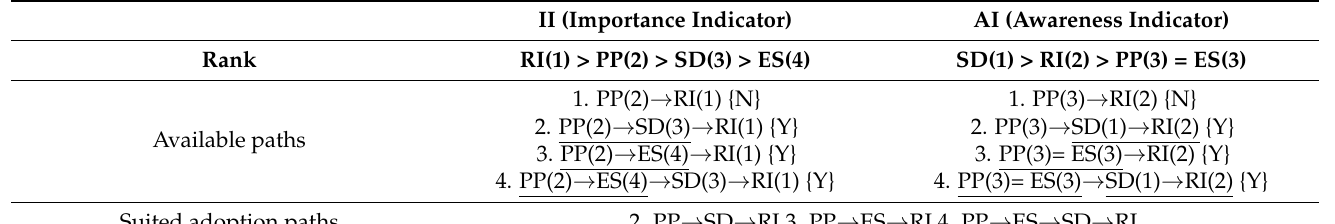
Table 7. The suited adoption paths of SDM competency development for attending physicians.